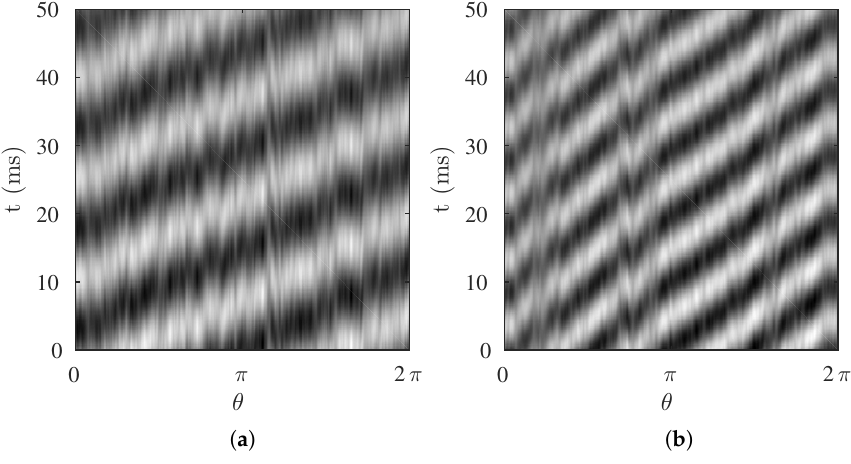
Figure 9. Space-time cross correlation of the tangential velocity fluctuating component along the azimutal direction at m = 0.6 and in the middle of the diffuser section at n = 0.5. ( a ) Flow angle α IN = 9.5 ◦ , tangential velocity fluctuation reconstructed from Fourier surface spectra modes at 0.04 f BPF and f BPF , respectively; ( b ) flow angle α IN = 5.5 ◦ , tangential velocity fluctuation reconstructed from modes at 0.03 f BPF , 0.07 f BPF and f BPF . The correlation is normalized, and the scale range is from